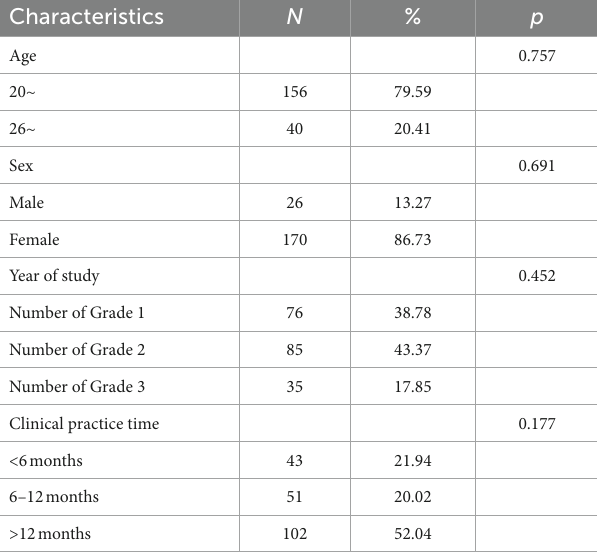
TABLE 1 Participants’ demographic characteristics ( N =